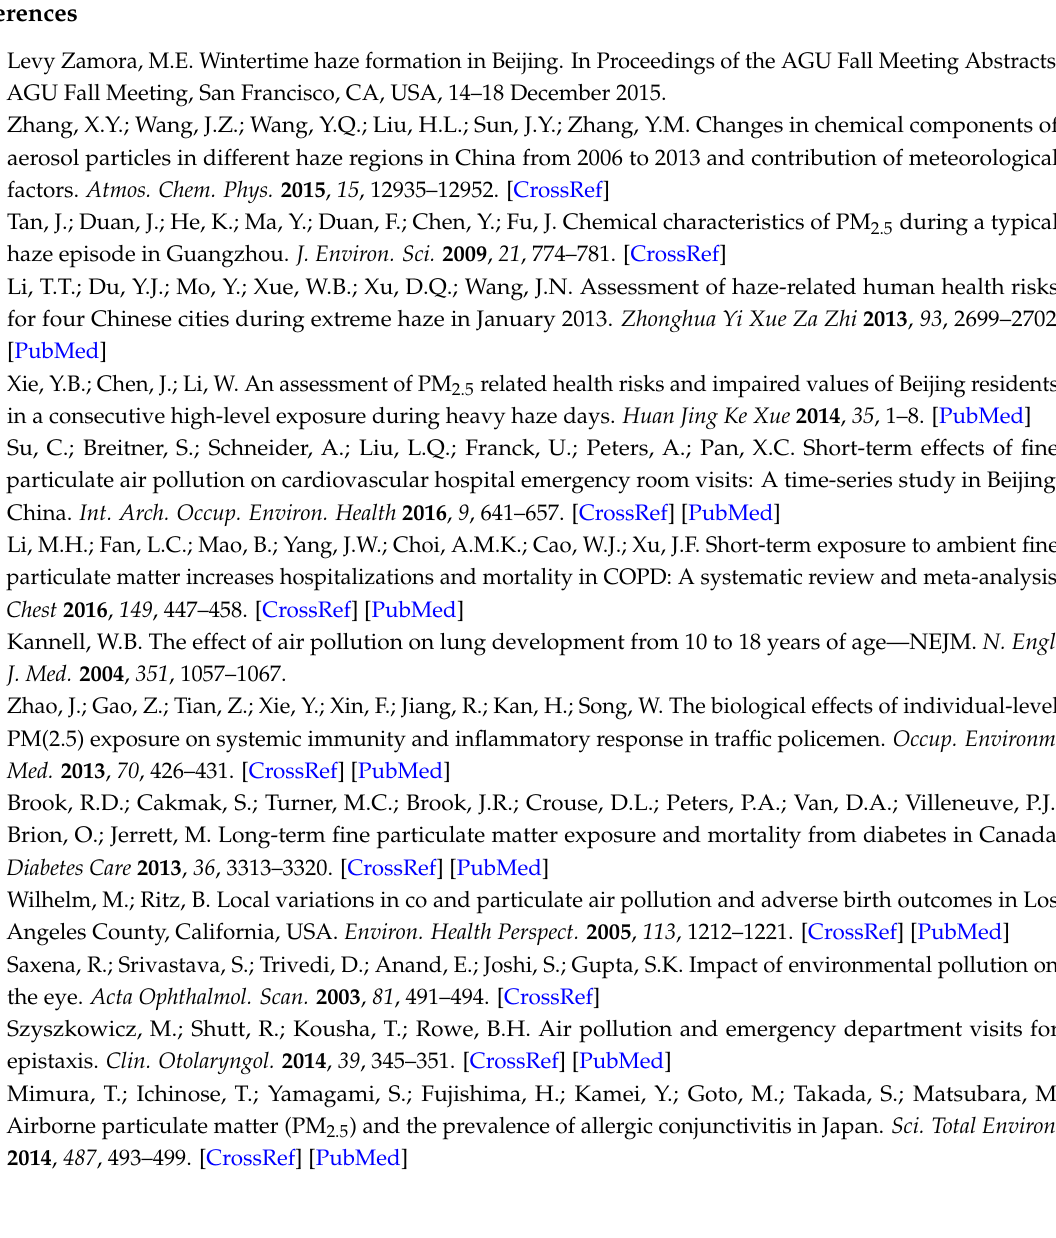
Table S1: Sensitivity analysis on the imputation for missing data of BC in the single-pollutant models. Table S2: Sensitivity analysis on the adequacy of linear terms of PM 2.5 or BC in the single-pollutant